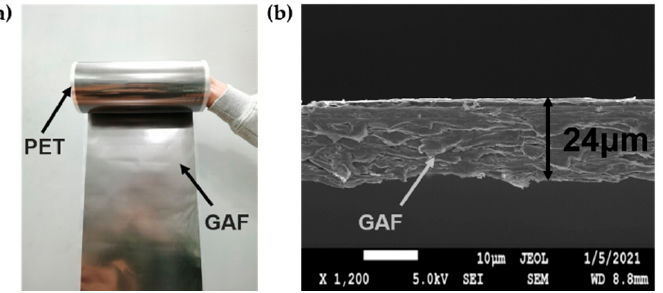
Figure 1. ( a ) Digital photo of the GAF. ( b ) Cross-sectional SEM image of the GAF.